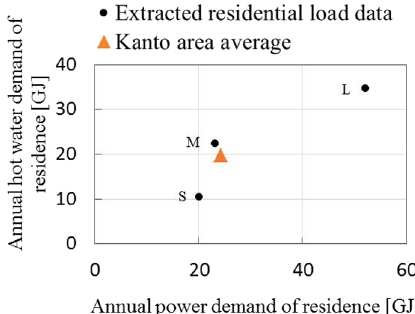
Fig. 8. Distribution of extracted residential load data.